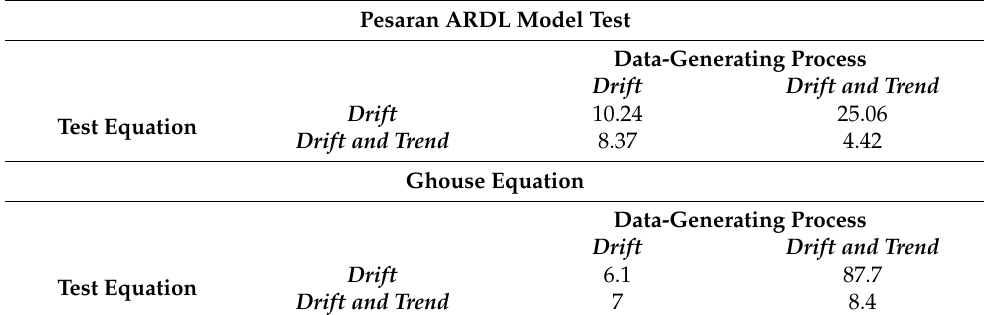
Table 4. Probability of spurious regression with Pesaran ARDL bound testing and the Ghouse